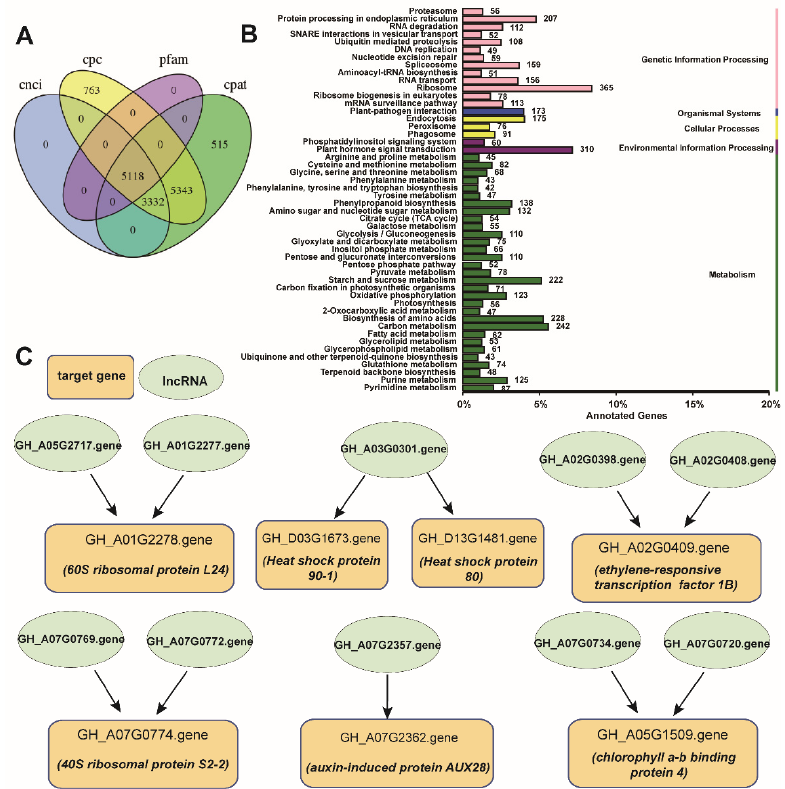
Figure 5. Analysis of the predicted lncRNAs and their target genes. ( A ) Statistics of the lncRNAs; ( B ) KEGG pathway enrichment analysis of the target genes; ( C ) the representative lncRNAs and their target genes.